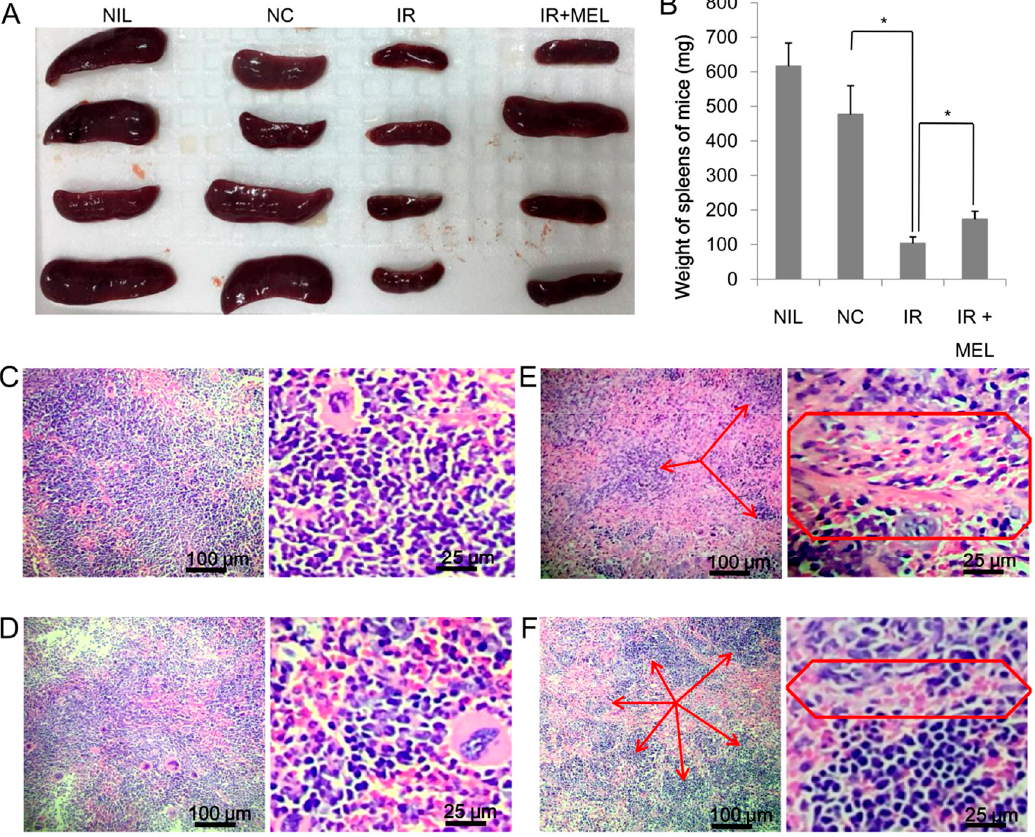
Figure 5. Spleen samples of mice in NIL, NC, IR and IR + MEL groups ( A ); weight of spleens of mice in each treatment group ( B ). Histological organization of spleens from mice in the NIL ( C ), NC ( D ), IR ( E ), and IR + MEL ( F ) treatment groups were observed under a microscope at two different magnifications of 1× (left panels) and 4× (right panels). The appearance of white pulp (arrows) and the reticuloendothelial system (boxed frame) with the presence of fibrous cells. NIL, mice with no induction of tumor or treatment; NC, mice receiving no treatment; IR, mice treated with a single dose of X-ray radiation; IR + MEL, mice treated with 40 mg/kg nanomelanin once before X-ray radiation and again 2 days post-radiation. *: Significant differences with P < 0.05.